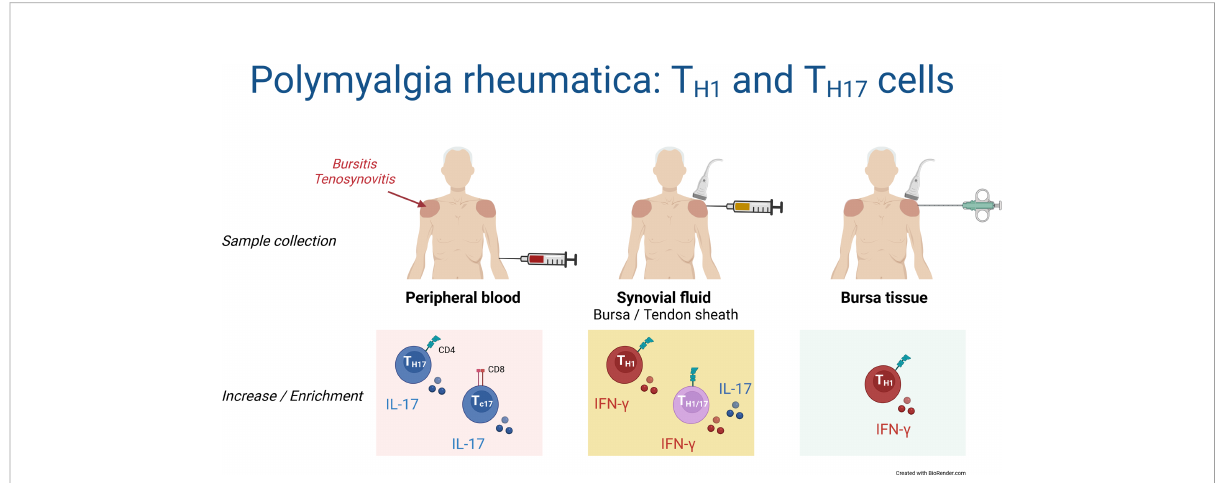
FIGURE 7 Schematic overview of T H1 and T H17 cells in blood, synovial fl uid and bursa tissue of patients with PMR. Findings in the current study are